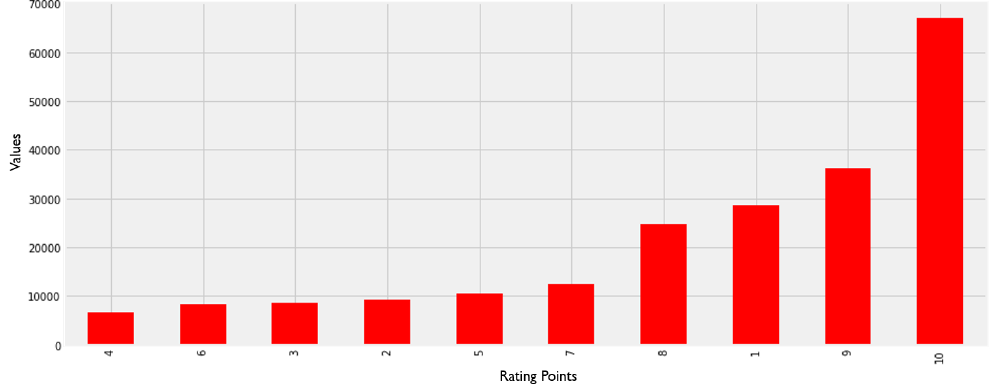
Figure 7. Drugs distribution with respect to rating provided by consumers.